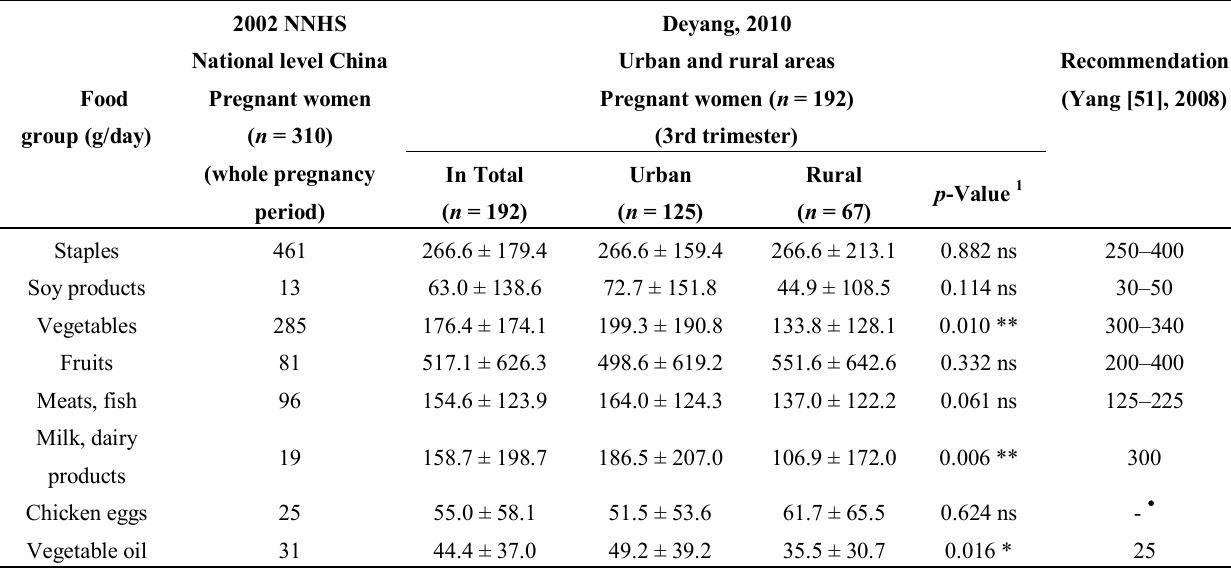
Table 5. Average amount of selected food groups consumed by pregnant women ( n = 310) in the 2002 NNHS [50] compared with consumption patterns of participants of our study ( n = 192) and recommendations by Yang, 2008 [51].